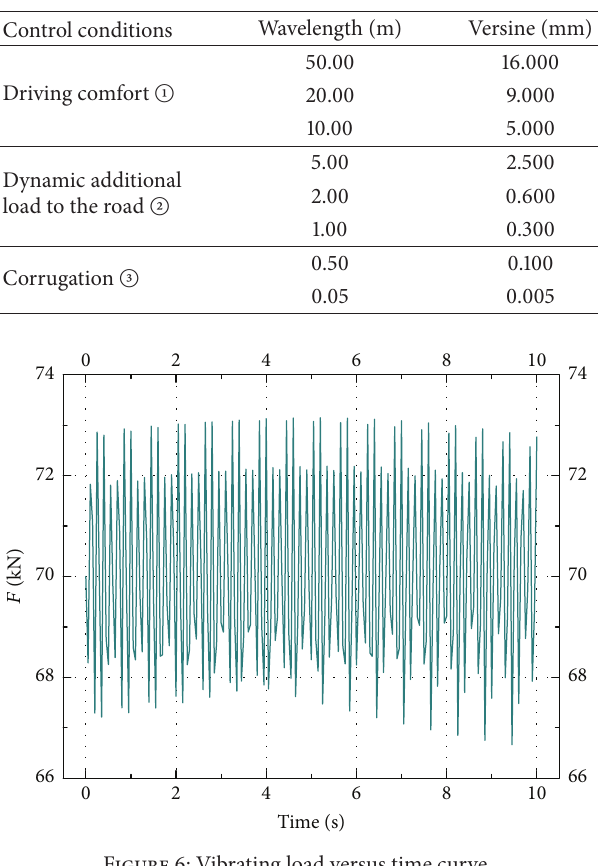
Table 4: Geometric parameters for UK railway engineering.